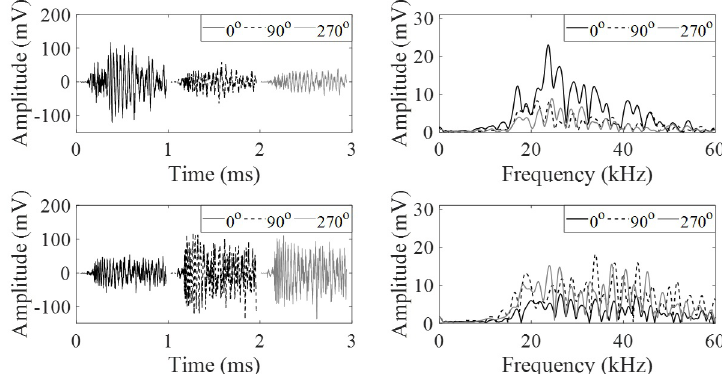
Figure 4. ( a ) Pencil lead break (PLB) waveforms in time and frequency domains at 0°, 90° and 270° at 25 a position with lens, and ( b ) without lens.